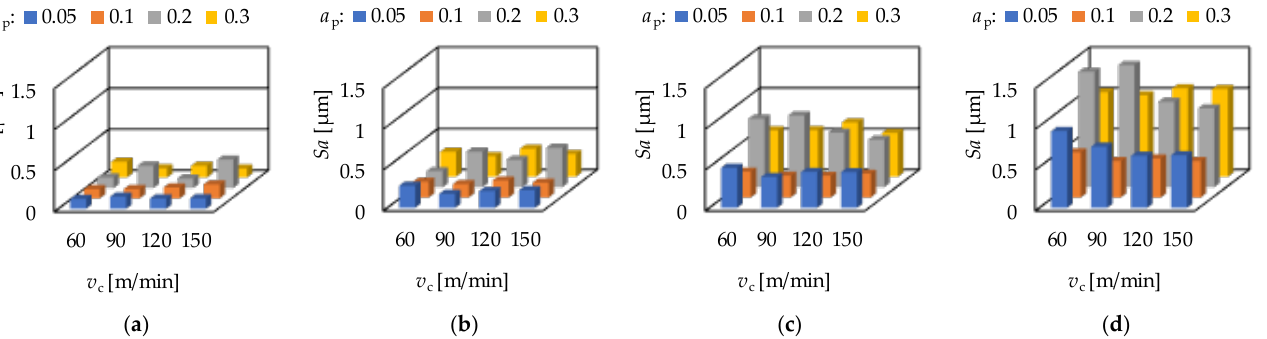
Figure 3. The measured arithmetic mean height ( Sa ) values for hard turning by applying ( a ) f = 0.05 mm/rev, ( b ) f = 0.1 mm = rev, ( c ) f = 0.15 mm/rev, ( d ) f = 0.2 mm/rev.